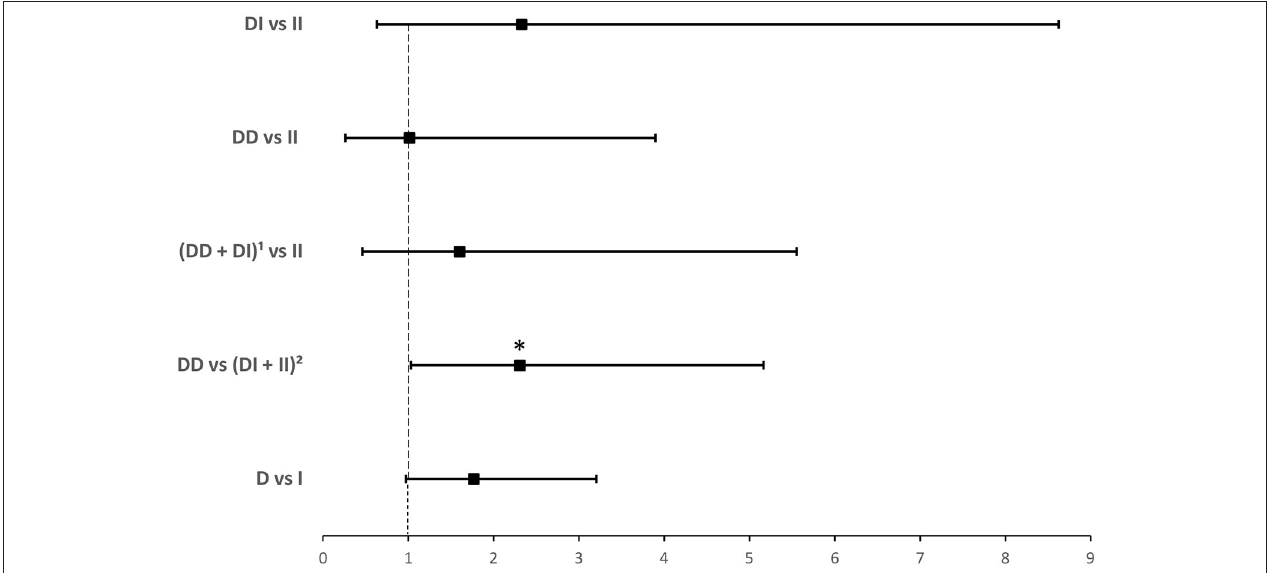
FIGURE 3 | Forest plot showing adjusted odds ratios ± 95% confidence intervals of ACE1 polymorphism for hospitalization for COVID-19. Multivariate analysis included variables that were statistically significant in the association analysis shown in Table 3 ; * P < 0.05. 1 D allele carriers, 2 I allele carriers.